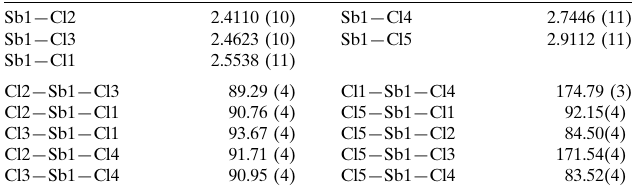
Selected geometric parameters (A˚ , (cid:2) ).